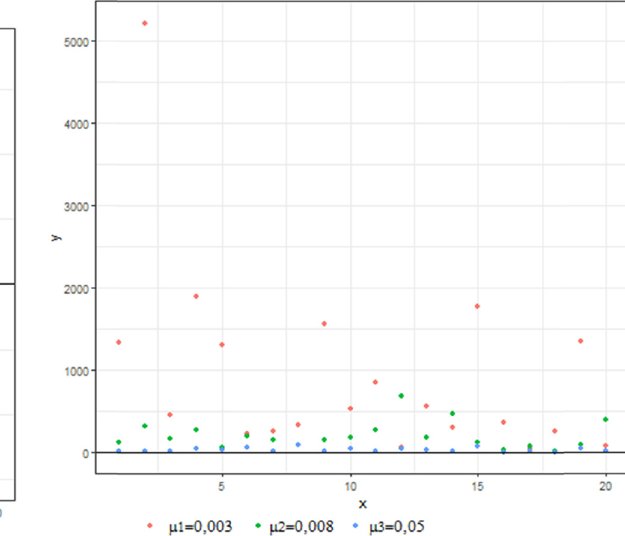
Figure 2: Simulation of transition between states at T = 1,000 con - secutive moments of time ( starting from state 0 – no pending reports ) , for a fi xed λ = 0, and three di ff erent values μ 1 = 0.003, μ = 0.008, and μ = 0.05. 2 3